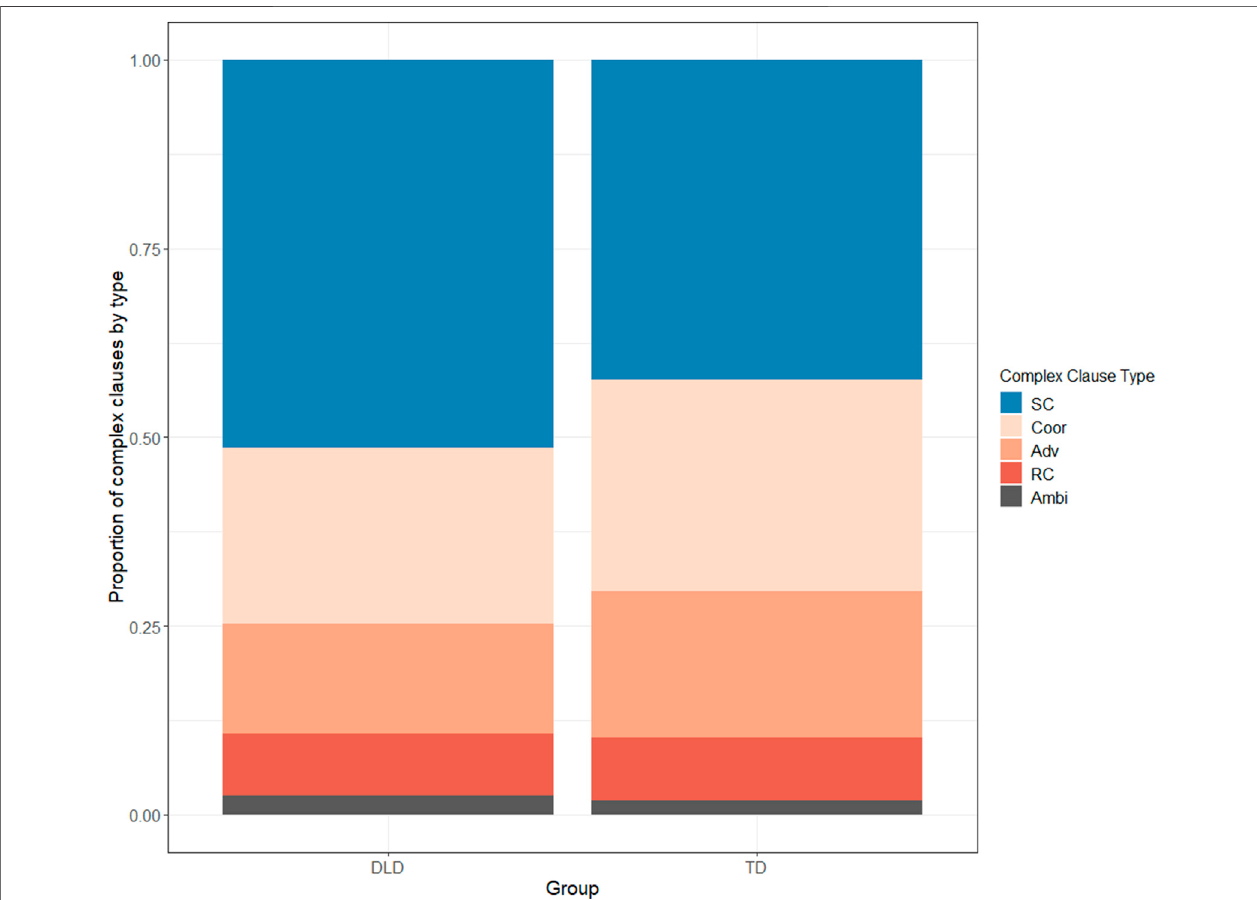
FIGURE 2 | Proportion of complex clauses by type and by group. Note: TD (cid:1) typical development; DLD (cid:1) developmental language disorder; Coor (cid:1) coordinated clauses; RC (cid:1) relatives clause; Adv (cid:1) adverbial clauses; SC (cid:1) sentential complement clauses; Ambi (cid:1) ambiguous clauses.